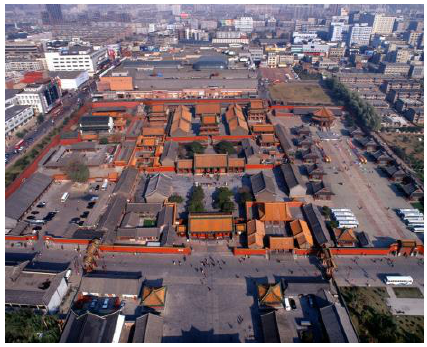
Figure 1. The aerial view of Mukden Palace